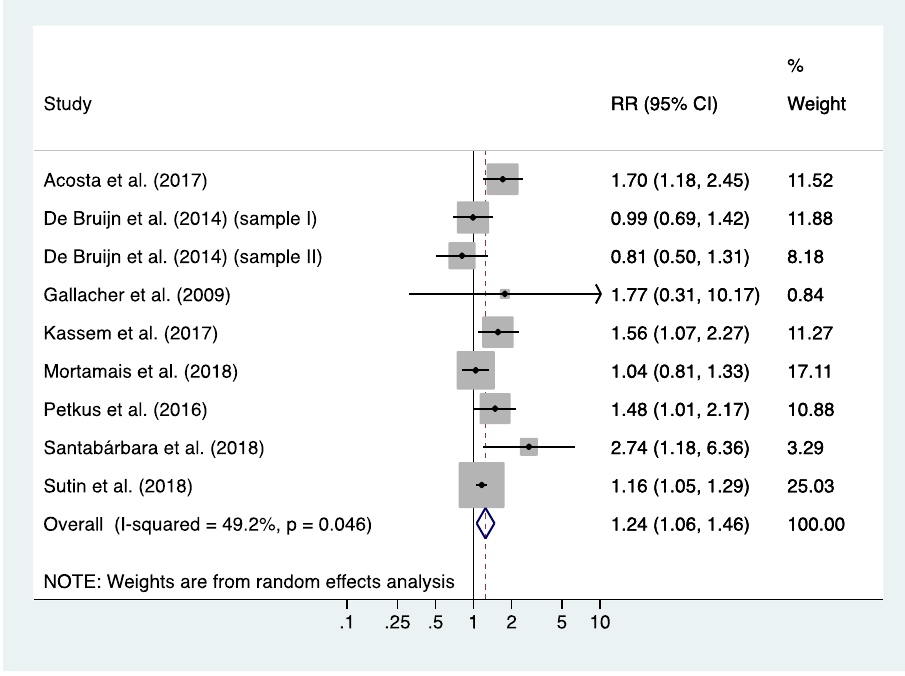
Figure 2. Meta-analysis of risk ratios for the association between anxiety and all-cause dementia.